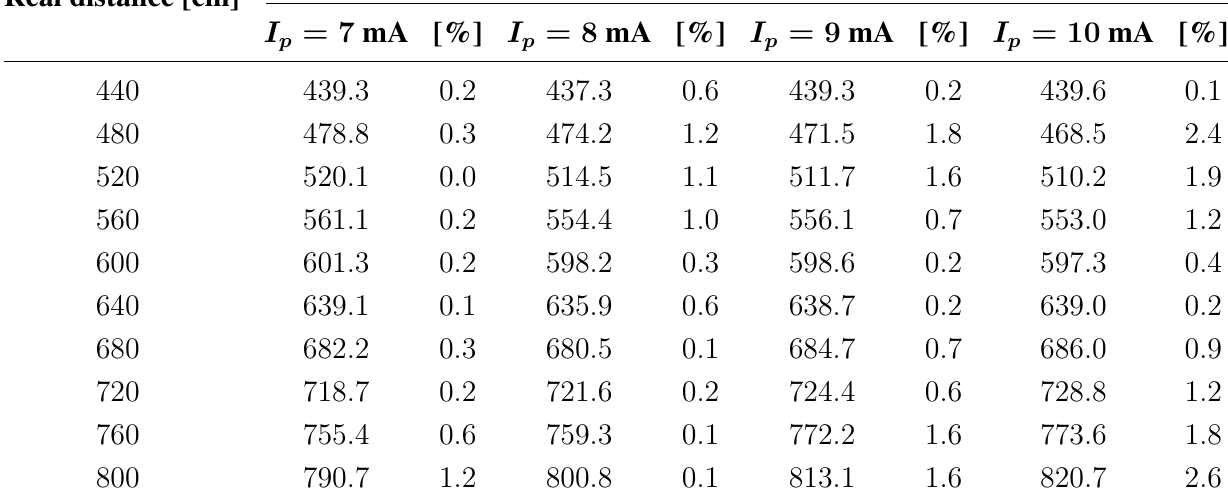
Table 2. Final distance estimation using the standard deviation of pixel gray-level intensities in an IRED image together with a differential method using the optimum exposure time